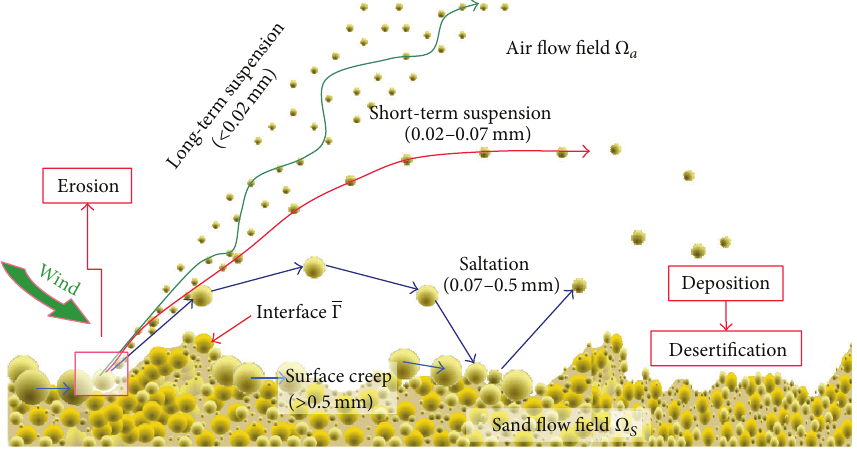
Figure 1: Different mechanisms of sand